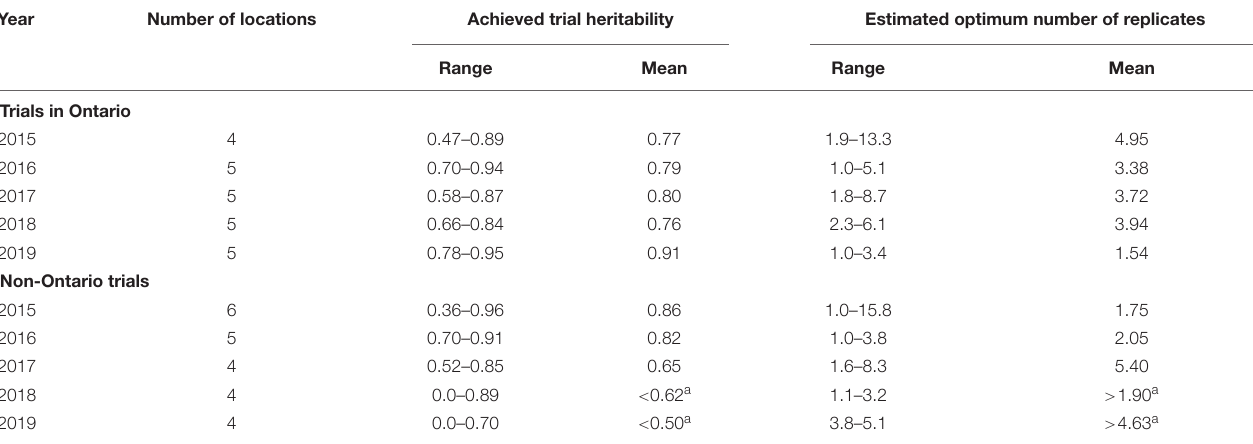
TABLE 2 | Achieved trial heritability and estimated number of replicates to achieve a trial heritability of 0.75 for each of the